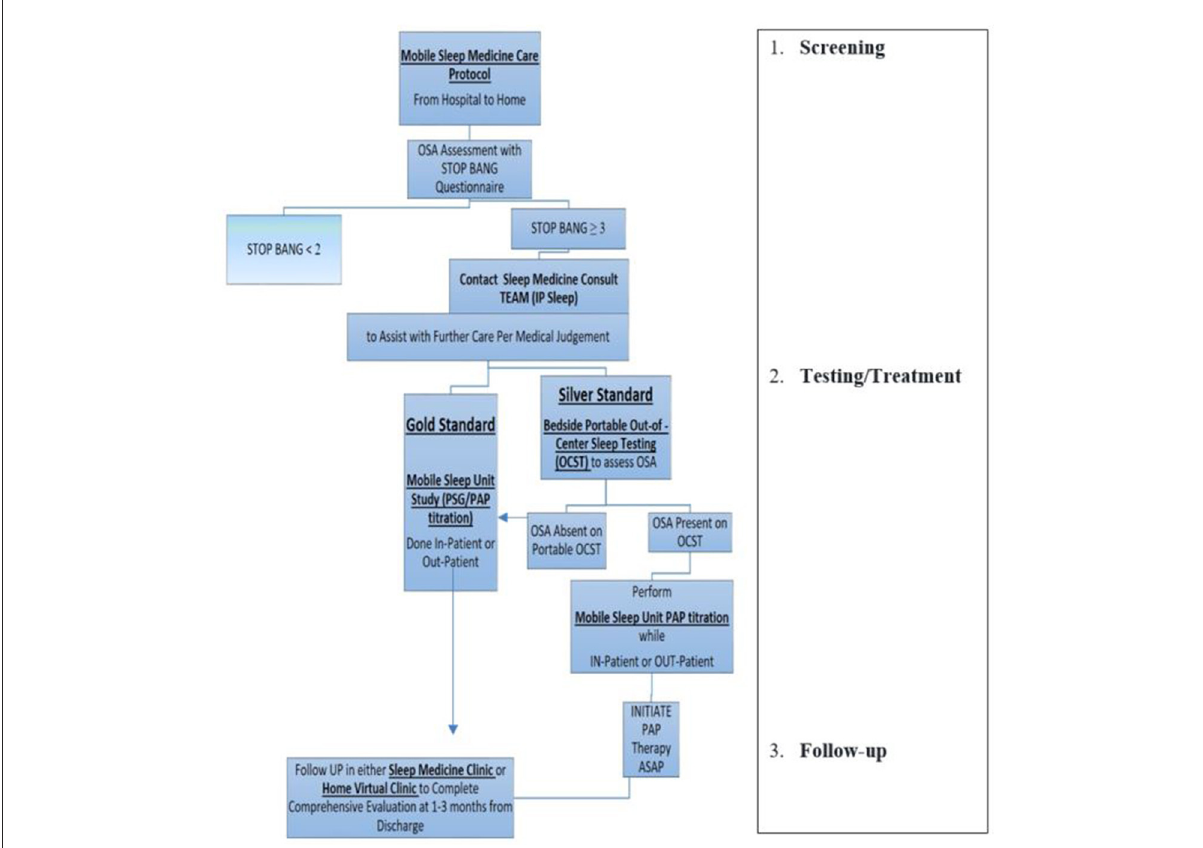
FIGURE1 Example of mobile sleep medicine care protocol. (1) Screening: Designed to provide effective and efficient SDB screening for patients admitted to hospital (or any other health care facility, e.g., rehab, specialty/subspecialty clinic, etc.), including patients with a high risk of CCV (stroke, MI, CHF, atrial fibrillation, hypertension, preeclampsia, etc.). After completing SDB screening either in-person, via EMR, or via Tele-Virtual/My Chart system, the Primary Team communicates with the Mobile Sleep Medicine Team/ in-patient Sleep Medicine Consulting Team (IP Sleep) to request sleep consultation for further management. (2) Testing/Treatment: The board-certified sleep medicine physician from the integrated mobile sleep medicine Team will discuss the sleep study results with patients and coordinate further management. Designed to deliver timely sleep medicine expertise to patients who screen positive for OSA. The IP sleep/mobile sleep medicine team evaluates patients and develops the diagnostic and treatment plan using mobile sleep unit technology. (3) Follow-up: IP sleep/mobile sleep medicine team coordinates further sleep medicine care in a sleep clinic, sleep lab, home health, and virtual telemedicine health. https://d11tooehygcg9z.cloudfront.net/My.AASM/ AgentsOfChange/587417.pdf; https://aasm.org/winners-of-inaugural-change-agents-competition-propose-new-approaches-for-sleep-